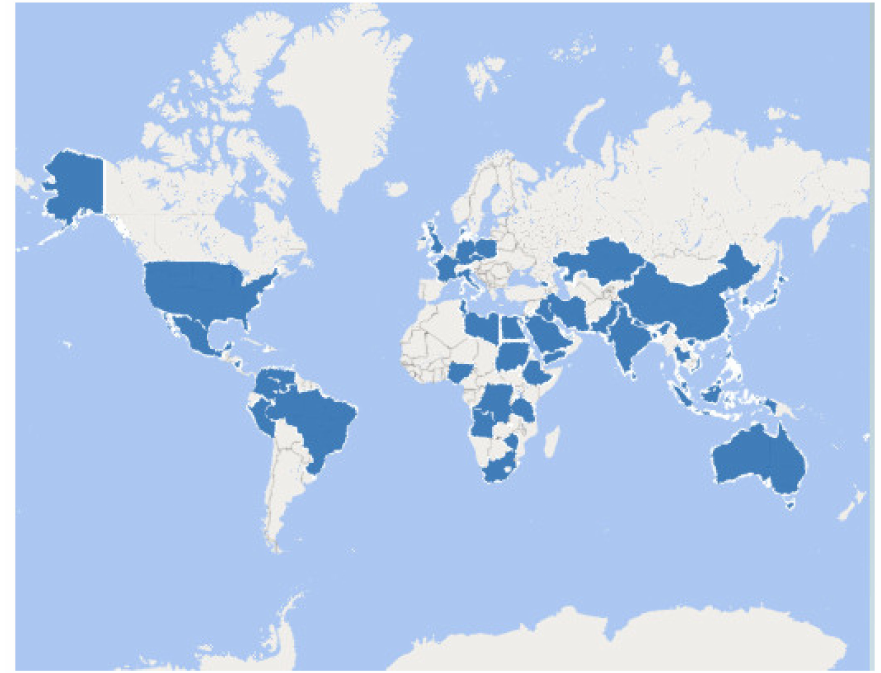
Figure 3. Nationalities of the participating international students in the included studies. The dark blue color indicates the countries of participating international